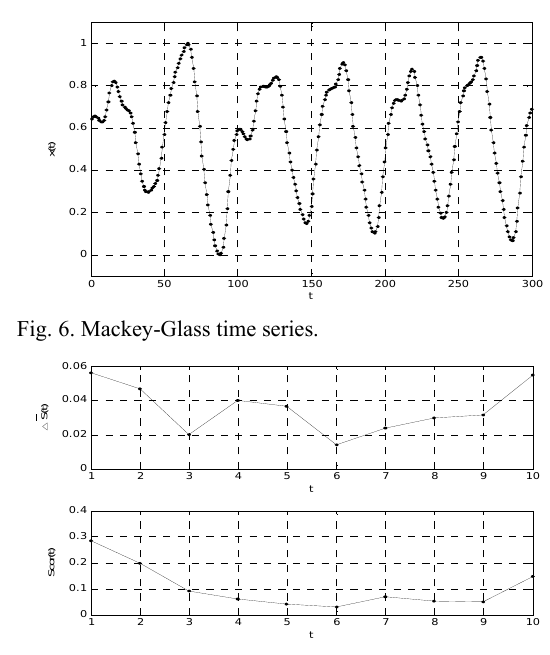
Fig. 7. Henon time series. Fig. 8. C-C method analyzing x component of Lorenz time series.